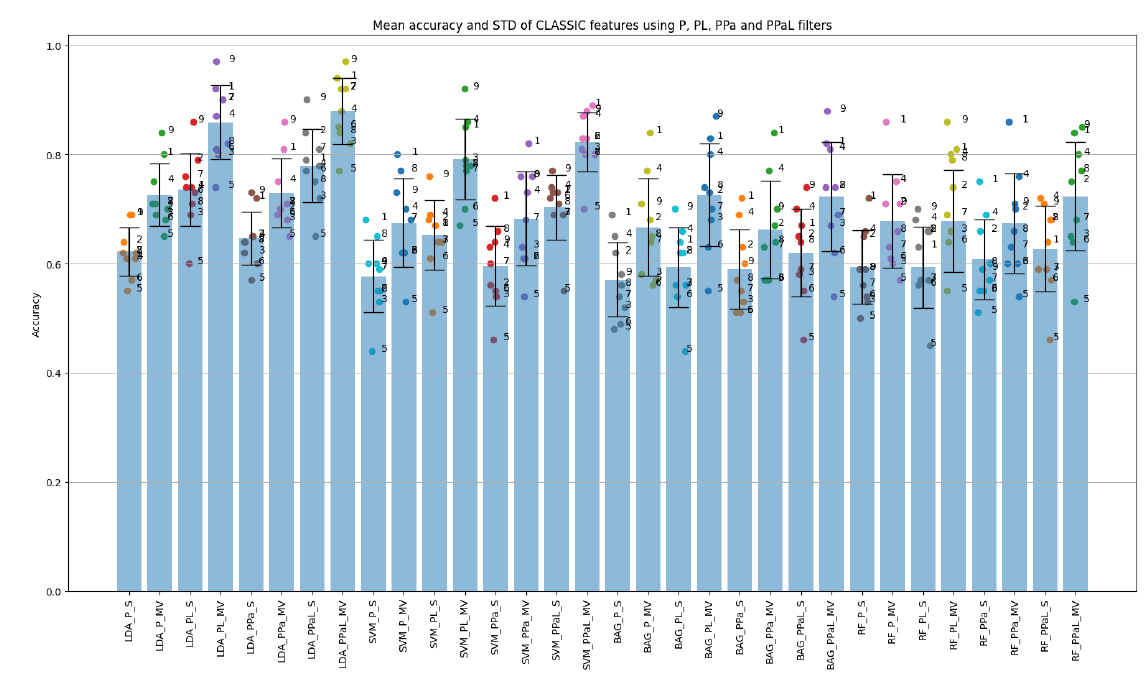
Figure 2. Accuracy value distributions across users for the most promising combinations of Table